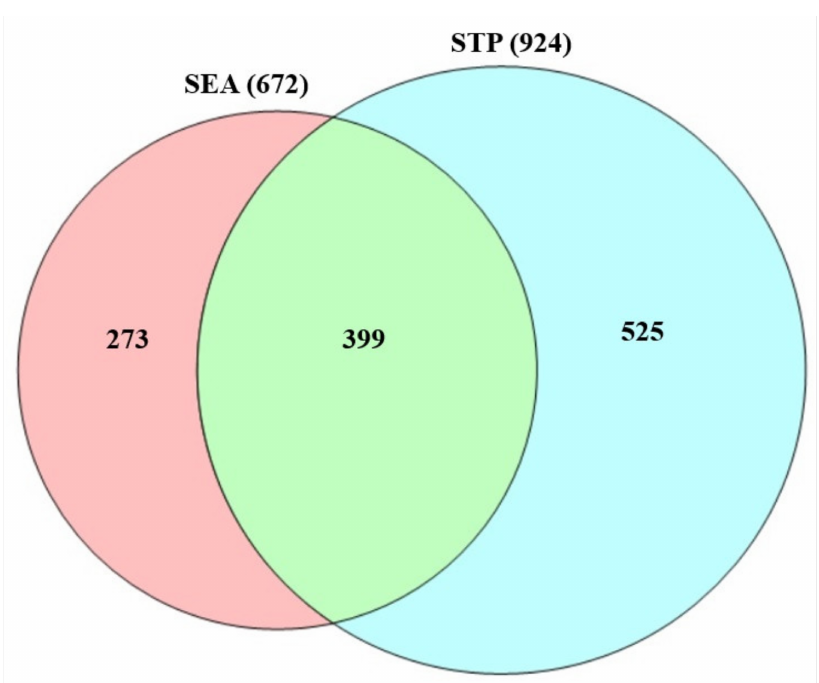
Figure 2. Overlapping genes (399 genes) between SEA (672 genes) and STP (924 genes).